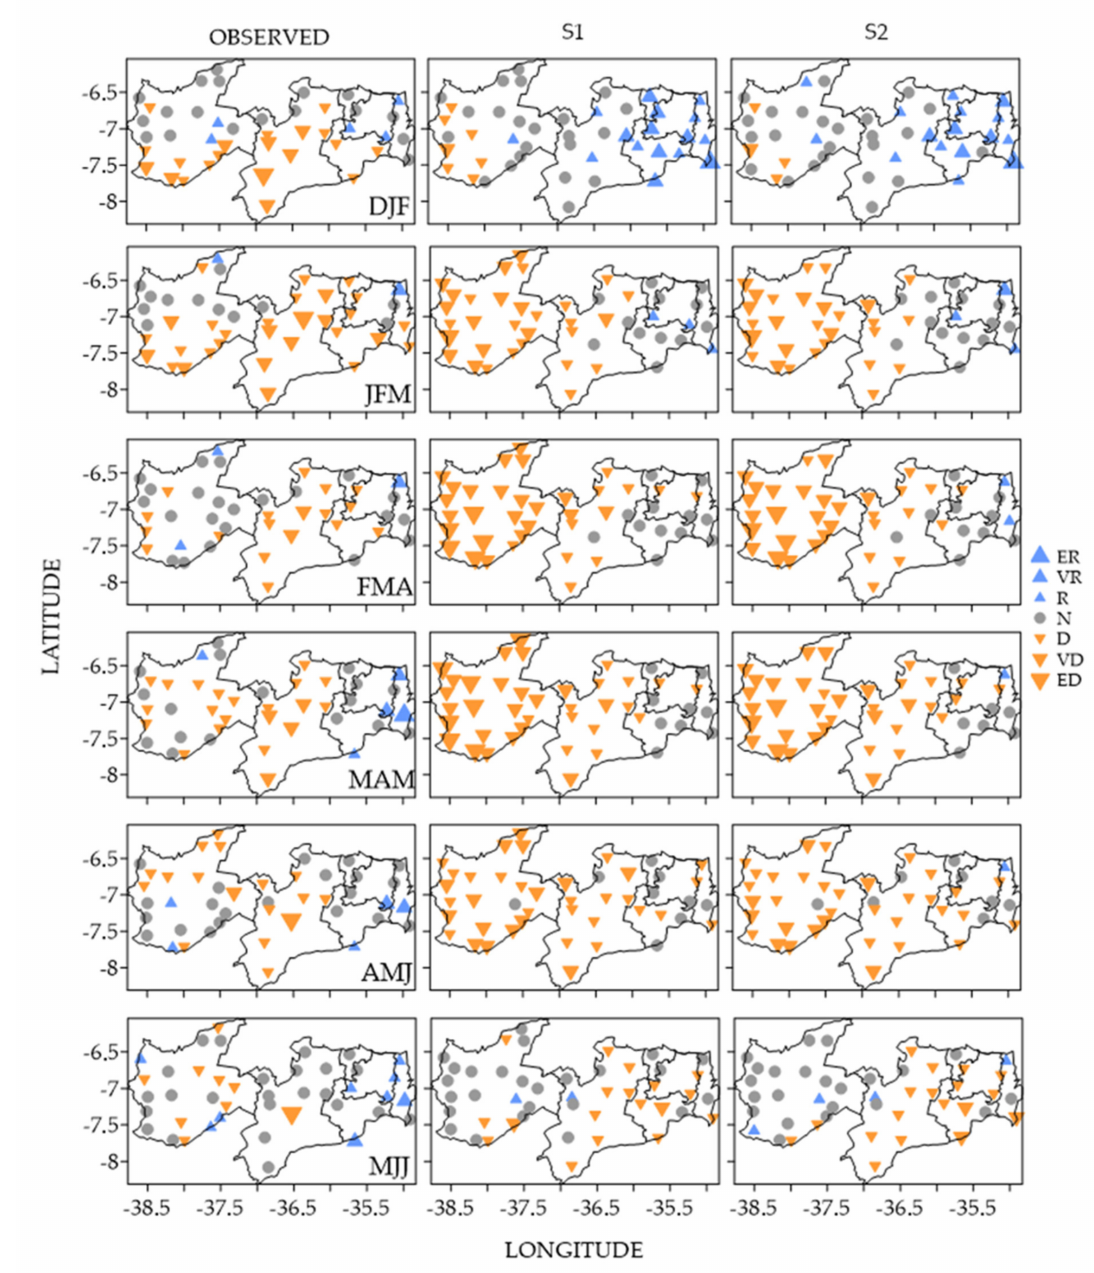
Figure 8. Quantiles of values observed and simulated by the GAMLSS model for S1 and S2 scenarios in Para í ba state for 2017 (Legend: ER = Extremely Rainy ( (cid:78) ), VR = Very Rainy ( (cid:78) ), R = Rainy ( (cid:78) ), N = Normal ( • ), D = Dry ( (cid:72) ), VD = Very Dry ( (cid:72) ) and, ED = Extremely Dry ( (cid:72)